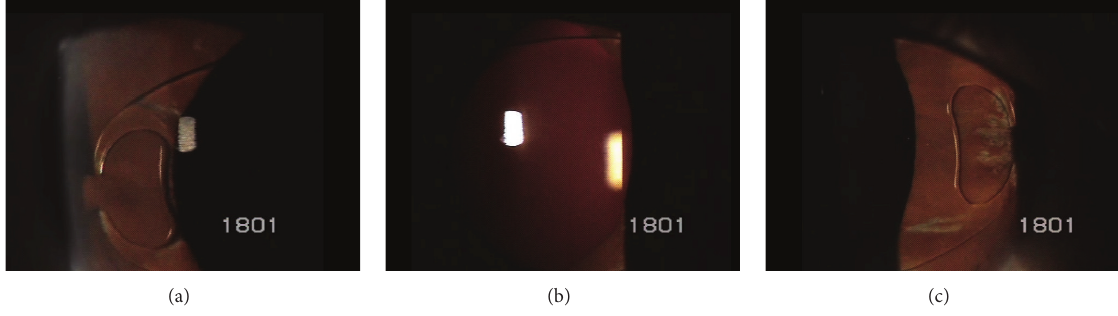
Figure 5: After three months Artisan phakic IOL was implanted (a to